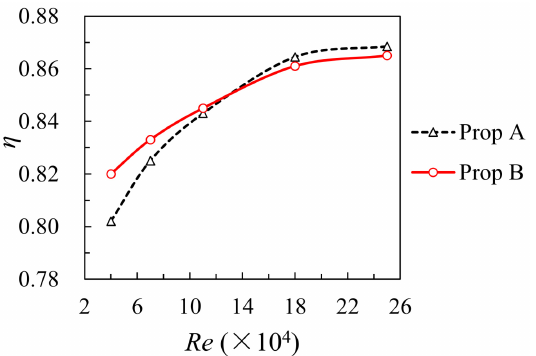
Figure 22. Aerodynamic performances of Prop A and Prop B at their design advance